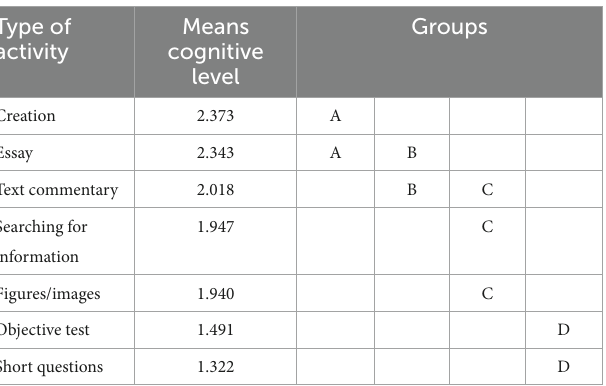
TABLE 14 Tukey-B test cognitive level and historical